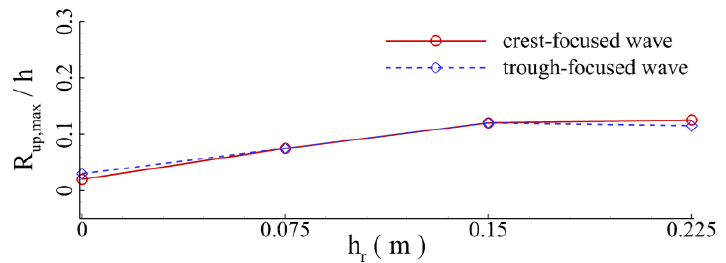
Figure 40. Maximum wave runup height versus the submergence water depth.